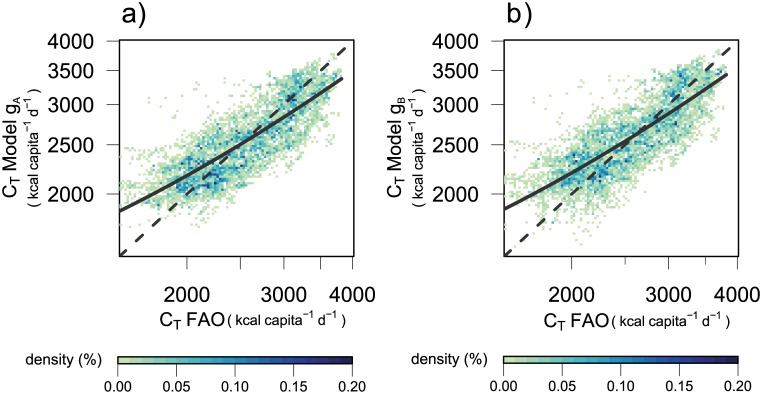
Model estimation for total calorie demand C
T a) with formulation g
A (Eq (3), SRES scenarios A1 & A2) and b) with formulation g
B (Eq (5), SRES scenarios B1 & B2). Comparison of reported and modelled total calories given as frequency in percent of the number of data pairs (colorscale below). Lines denote the linear regression (solid, values see Table 3) and 1:1 line (dashed). Note log scale of axes.